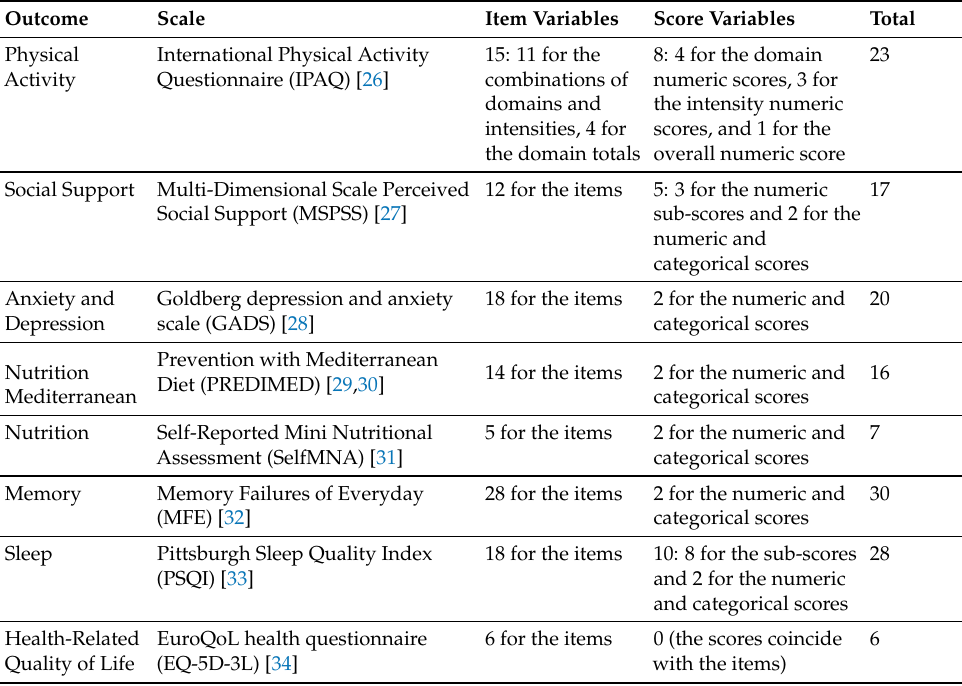
Table 2. Variables derived from the